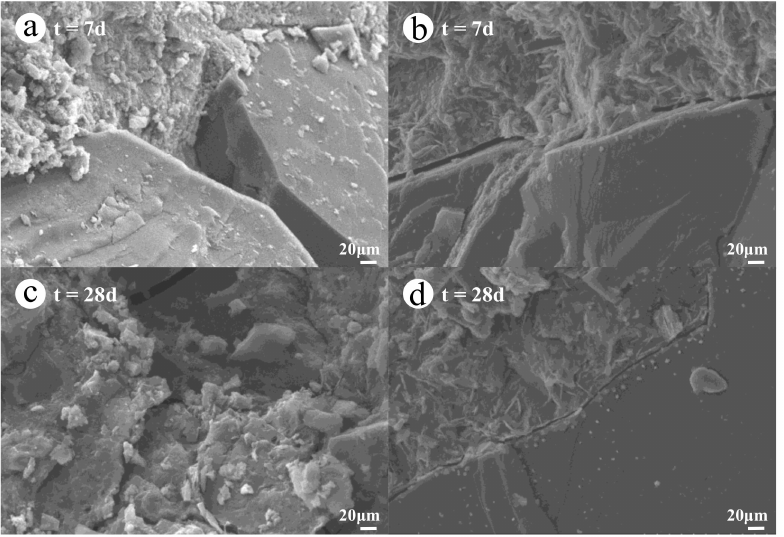
Figure 4. SEM of the G70N5 blocks: ( a , b ) t = 7 days; ( c , d ) t = 28